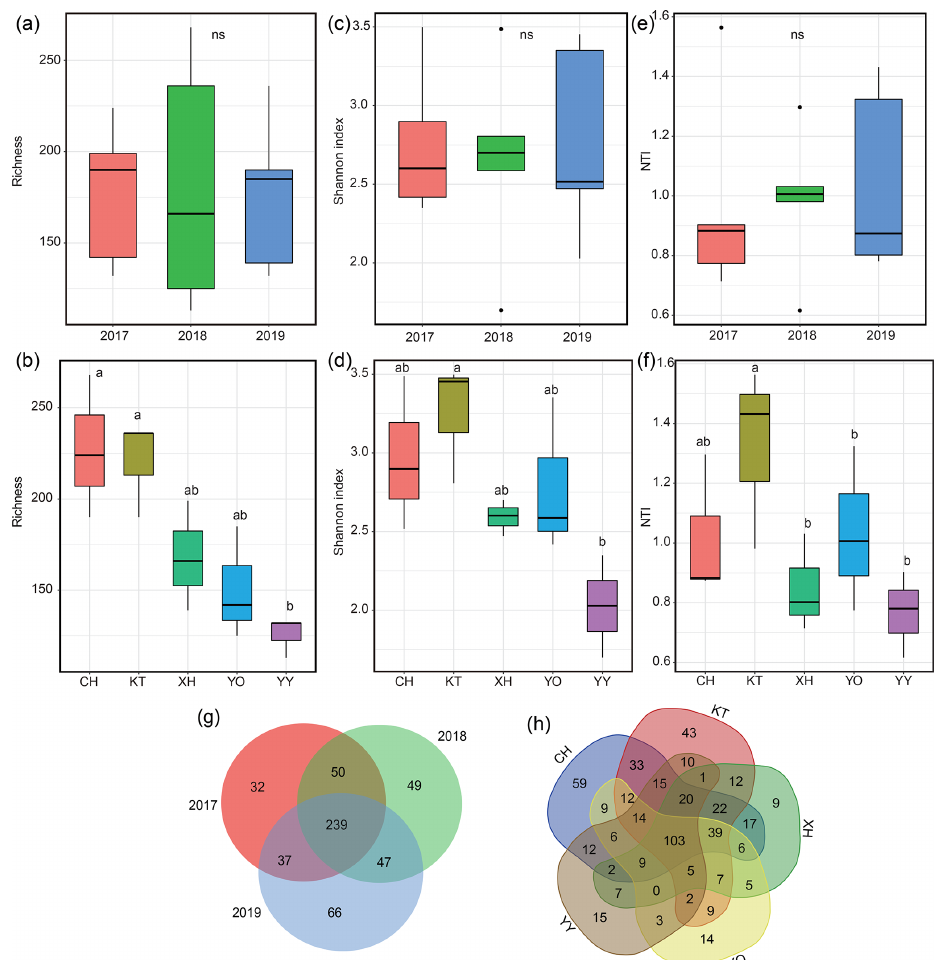
Figure 3. Microbial diversity and Venn diagram for different years and lakes. (a, b) Variations in the number of microbial operational taxonomic units (OTUs); (c, d) variations in the microbial Shannon index; (e, f) variations in the within-community nearest-taxon index (NTI); (g, h) Venn diagram showing the unique and shared OTUs. Homogeneity and one-way ANOVA analyses of variance were used to test the significance of the indices; “ns” represents no significant differences ( P > 0 . 05); significant differences ( P < 0 . 05) are indicated by different letters between lakes, and lakes containing the same letters showed no significant difference ( P > 0 .